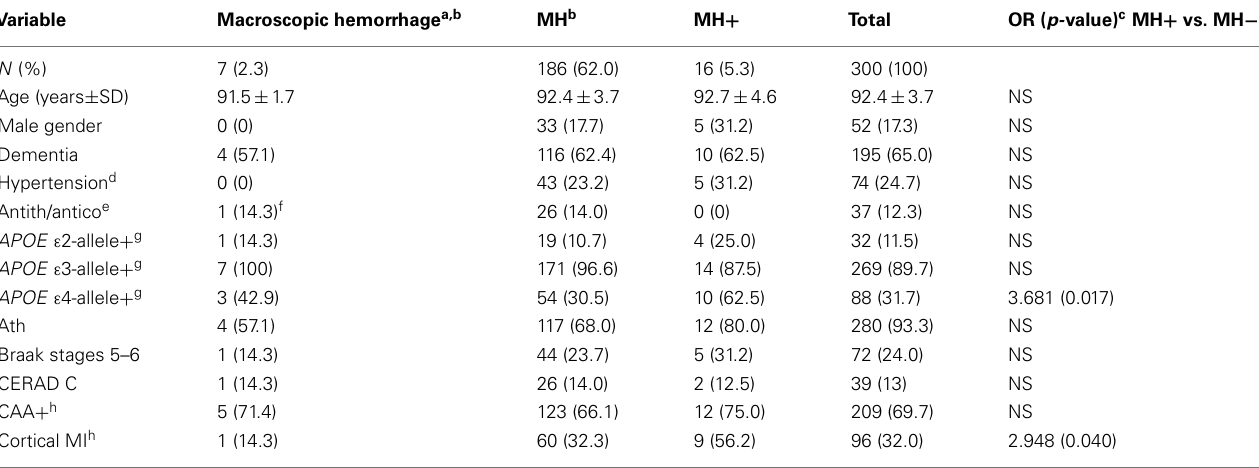
Table 2 | Characteristics of subjects with macroscopic and microscopic cerebral hemorrhages. Variable